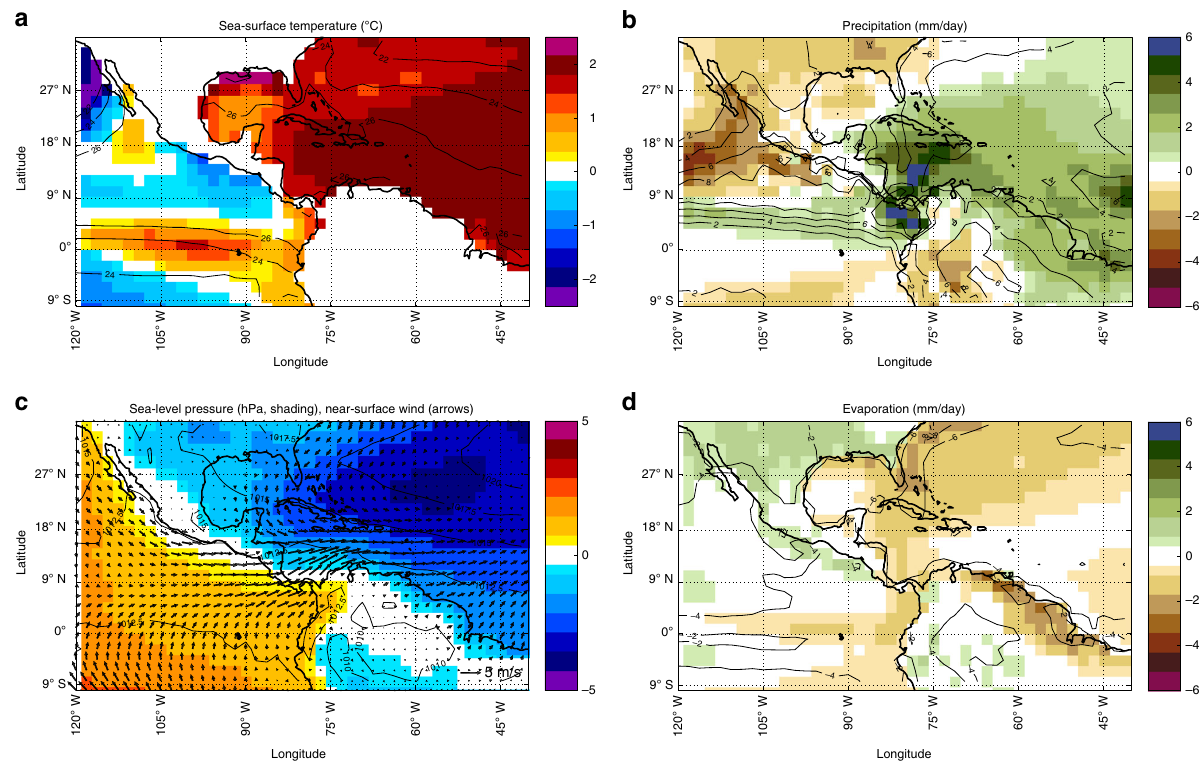
Fig. 4 Climate anomalies with a ~2 °C tropical Atlantic SST warming. Idealized simulation with the Max Plank Institution for Meteorology Earth System Model. Shadings are anomalies in sea-surface temperature ( a ), precipitation ( b ), sea-level pressure ( c ), and evaporation ( d ) between peak warm Atlantic Multidecadal Oscillation (AMO) and peak cold AMO anomalies from six idealized 70-year sinusoidal AMO cycles; line contours identify the associated climatologies (see ref. 45 for details). Arrows in panel c represent warm-cold differences in 10 m winds. Peak warm and peak cold values are determined as 11-year averages around the warmest and coldest year in each AMO cycle,